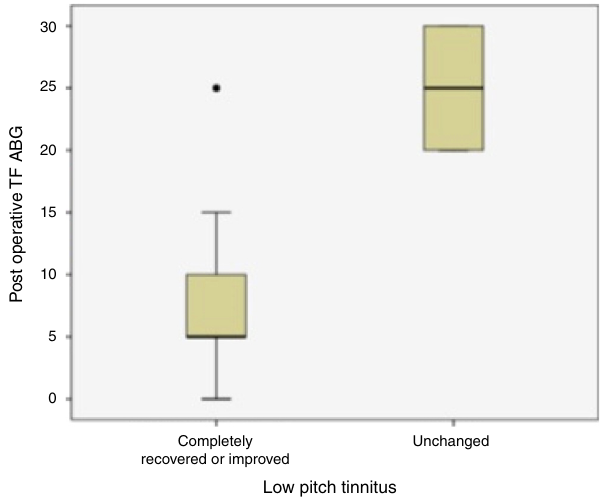
Figure 3 Comparison of low pitch tinnitus status and postop- erative ABG values at tinnitus frequencies was presented (TF ABG, Tinnitus Frequency Air-Bone Gap